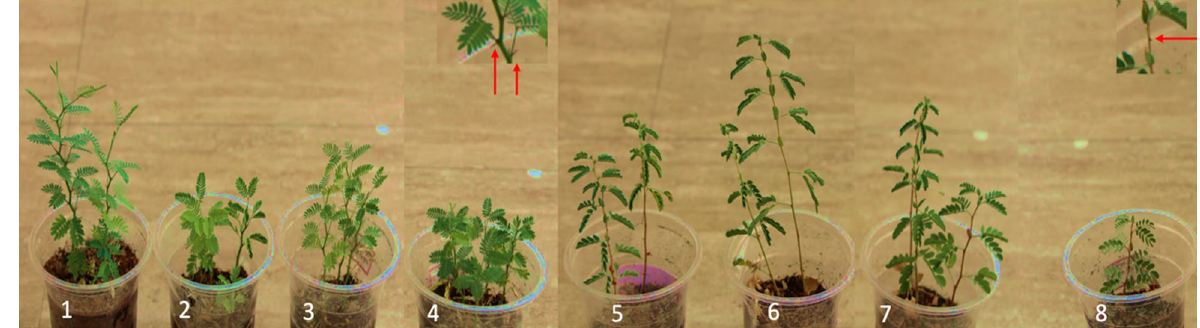
Fig. 2 Effect of soil biota exclusion and inoculation of PC1 and PJ1 isolates on the plant growth performance of Prosopis juliflora (PJ) and Prosopis cineraria (PC) . The numbers (1–8) refer to different growth medium combination, namely PJ in natural garden soil (1); PJ in sterile soil (2); PJ in sterile soil inoculated with PJ1 bacterial isolate (3); PJ in sterile soil inoculated with PC1 bacterial isolate (4); PC in natural garden soil (5); PC in sterile soil (6); PC in sterile soil inoculated with PC1 bacterial isolate (7); PC in sterile soil inoculated with PJ1 bacterial isolate (8). All the seedlings represent 12-week-old seedlings at the end of the experiments and the figures on top right corners indicate the presence of thorns in the Prosopis congeners. Thorns in PJ seedlings were more abundant and larger as compared to those of PC seedlings